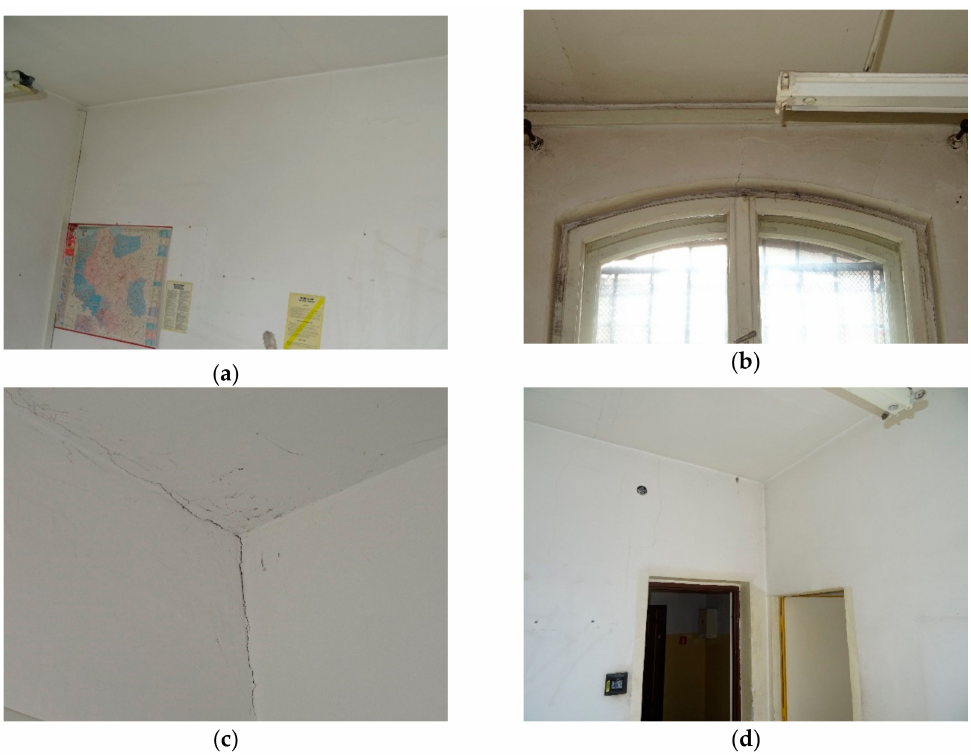
Figure 4. Interior damages: ( a ) wall cracks; ( b ) damages near the masonry arch lintel; ( c ) wall corner damages; ( d ) cracks near the ceiling base.